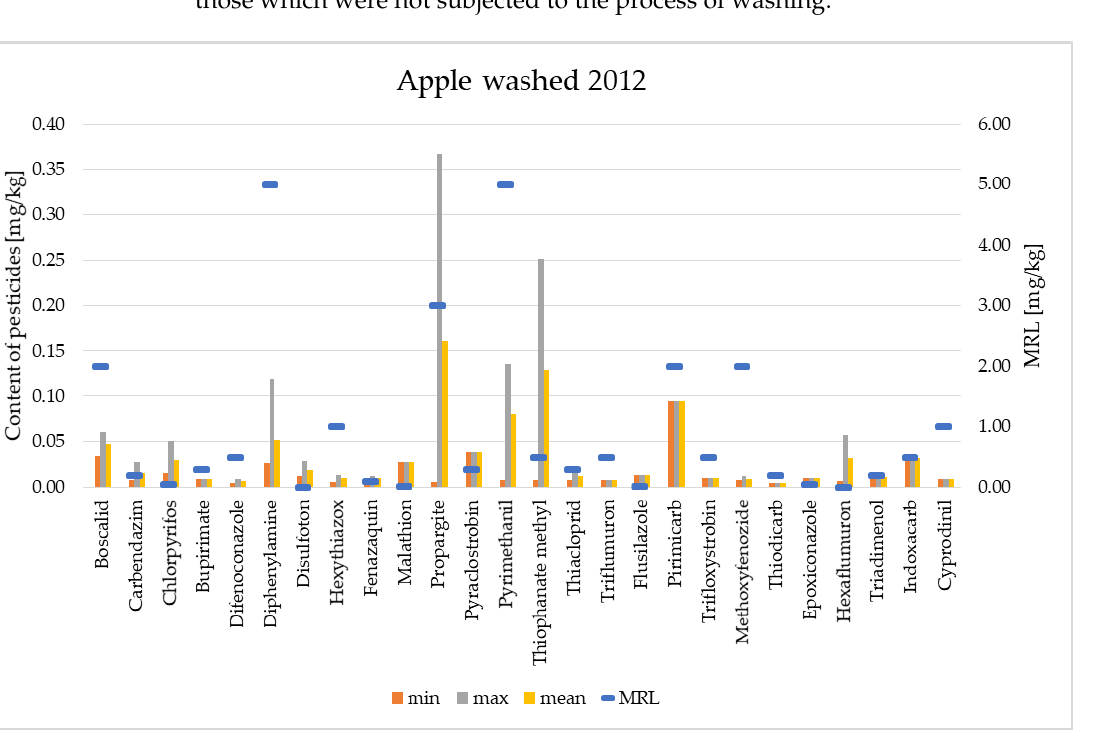
Figure 16. Content of pesticides in samples of apples washed with water (2020).